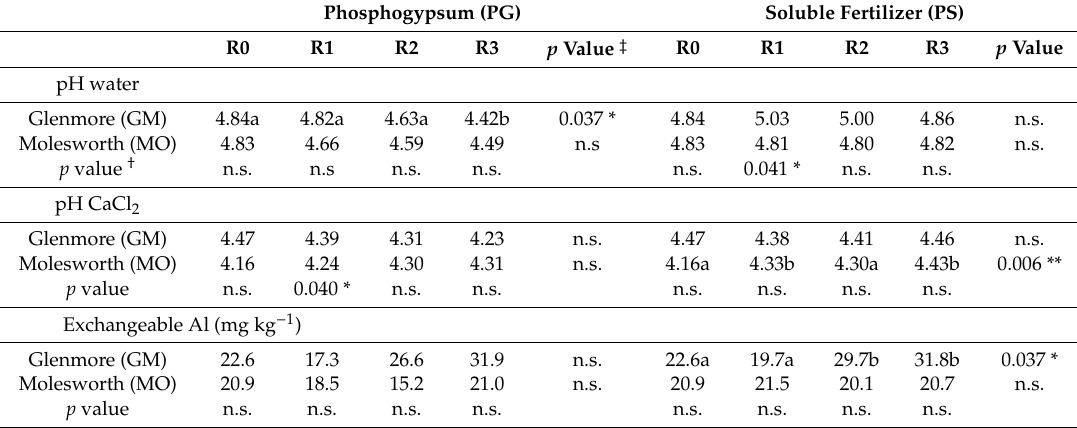
Table 4. E ff ects of phosphogypsum and soluble fertilizer on soil pH (water and CaCl 2 ) and exchangeable aluminum in both Glenmore and Molesworth soils under no lime application, after six months plant growth period. Within rows, means followed by the same lower-case letter are not significantly di ff erent (Dunnett test at 5%, R0 = control). Within columns, means were compared using a two-sample t -test at 5%.